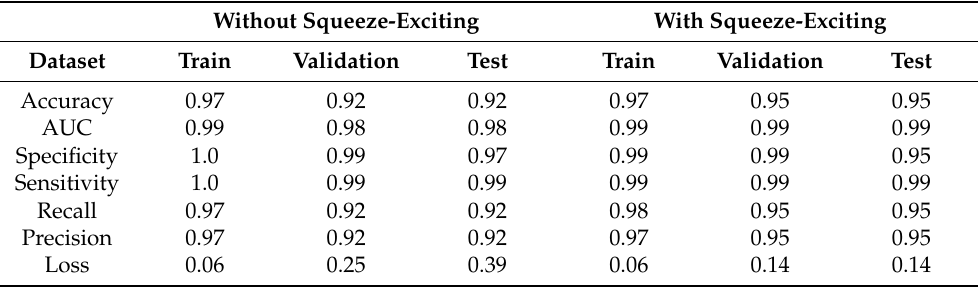
Table 1. Comparison between metrics achieved without and with squeeze-exciting blocks for the train, validation, and test datasets. Without Squeeze-Exciting With Squeeze-Exciting